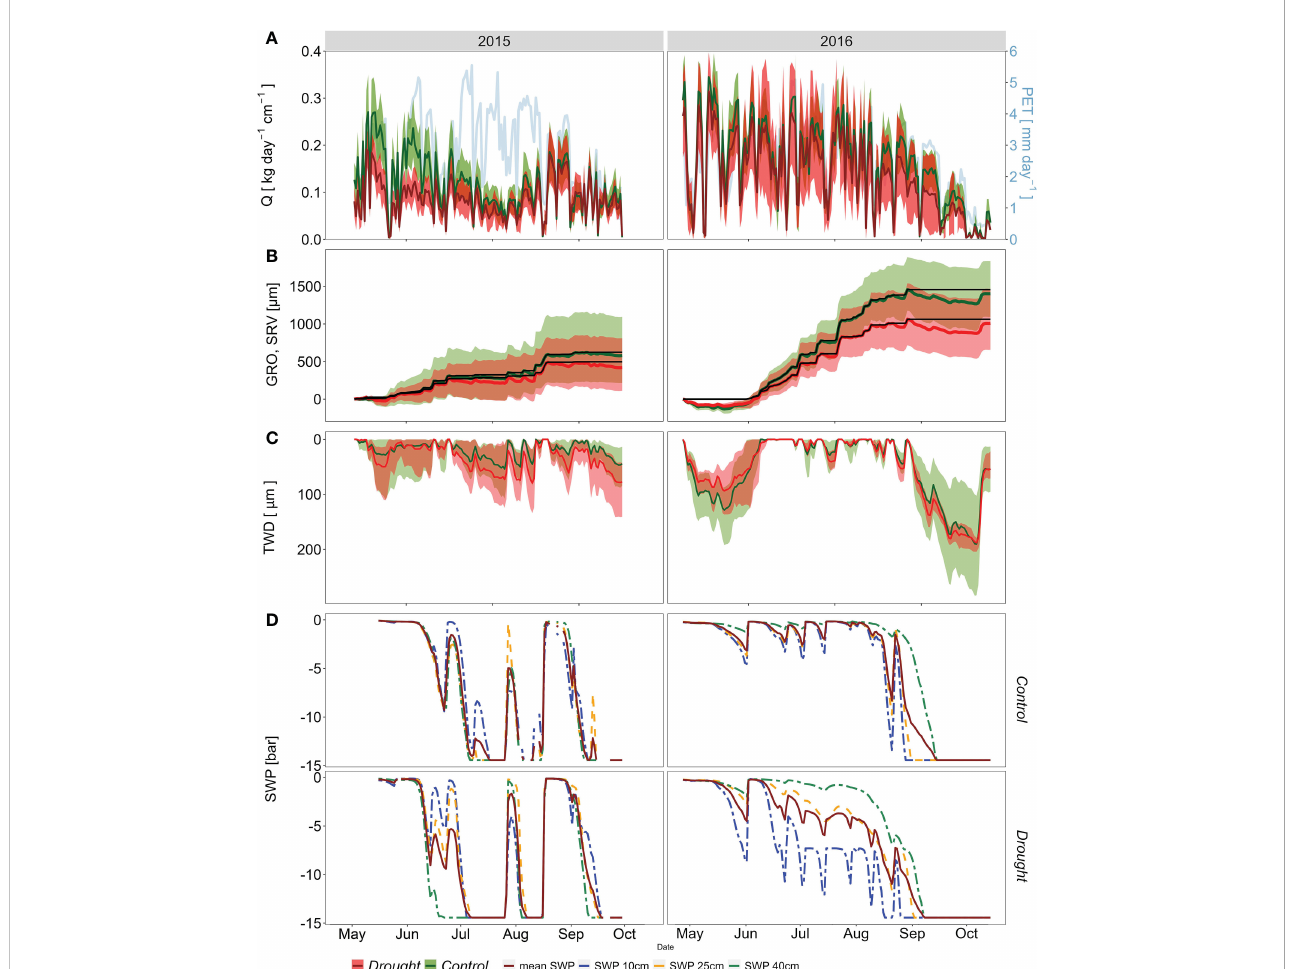
FIGURE 3 Seasonal dynamics of speci fi c sap fl ow - Q and potential evapotranspiration - PET (A) , stem radial variation - SRV (bold colored line) and modelled growth line - GRO (black line) (B) , daily tree water de fi cit - TWD (in absolute values) (C) , and mean soil water potential – SWP and at depths: 10, 25 and 40 cm, in PC (upper) and PE (lower) (D) in the growing seasons: 2015 (left) and 2016 (right). The curves in A)-C) represent mean values ± con fi dence